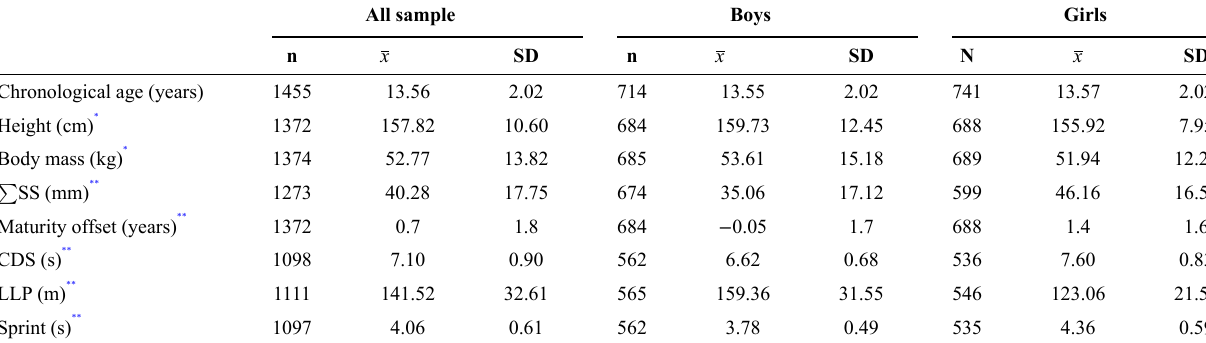
Table 1 - Description of the analyzed variables and differences between the sex of adolescents aged 10-17. All